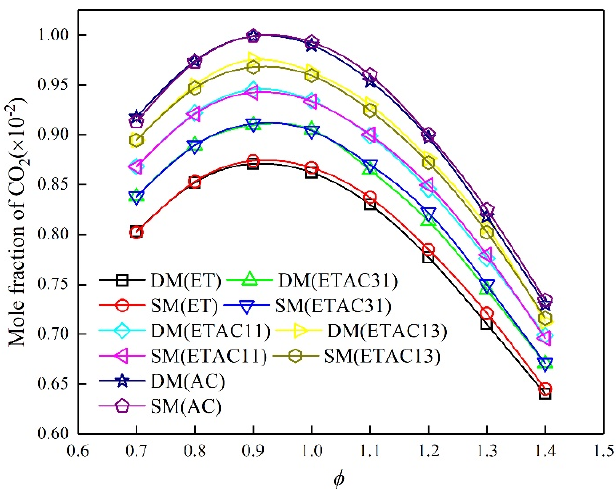
Figure 5. Comparison of CO 2 mole fraction calculated by skeletal mechanism and detailed mecha- nism. DM: detailed mechanism; SM: skeletal mechanism.